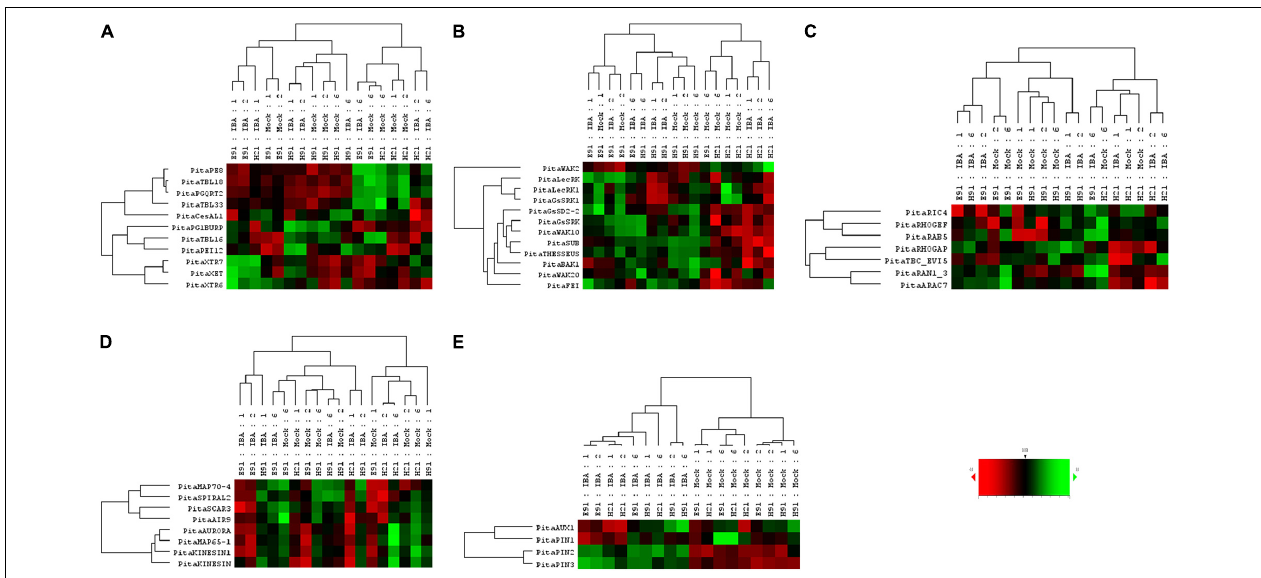
FIGURE 4 | Expression profile of genes encoding cell wall modification (A) , receptor-like kinases (B) , small GTPase-related (C) , cytoskeleton-related (D) , and auxin carrier (E) proteins in rooting-competent hypocotyl cuttings from 21-day-old seedlings (H21) and both non-competent hypocotyl (H91) and epicotyl (E91) cuttings from 91-day-old-seedlings during adventitious root formation. RNA was extracted from the bases of hypocotyl (H) and epicotyl (E) cuttings treated with 10 µ M indole-3-butyric-acid at the indicated times (days). Hypocotyl and epicotyl cuttings maintained in water were used as controls (mock). An agglomerative cluster analysis was performed based on Pearson’s distances between gene expression levels and plotted as a heat map with a dendrogram of sample and gene